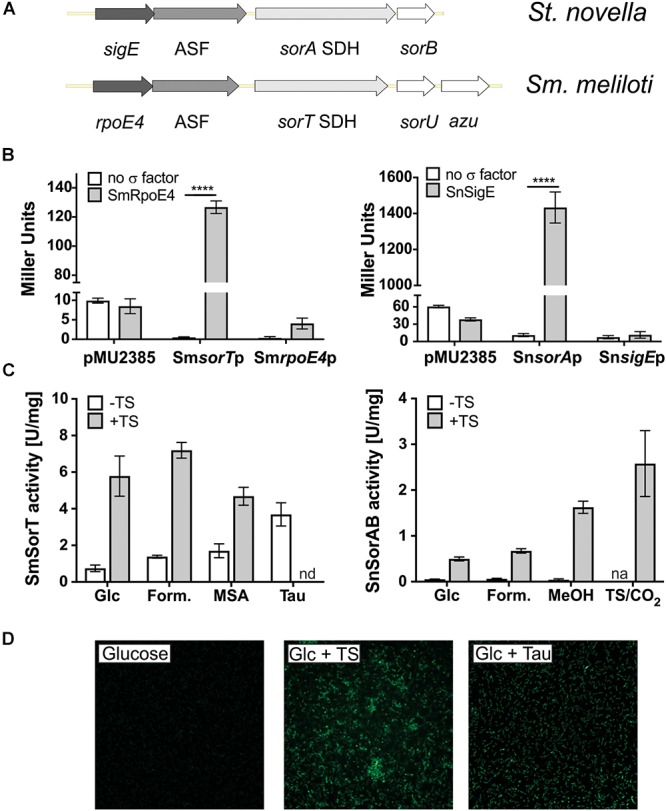
ECF sigma factor-based regulation of SOE gene expression in Sm. meliloti 1021 and St. novella. (A) Schematic representation of the Sm. meliloti rpoE4/sorT and St. novella sigE/sorAB gene regions, highlighting the similarity of the gene arrangement. (B) Reporter gene assays showing the ability of SmRpoE4 and SnSigE to activate the promoters of the cognate SOE encoding genes sorT and sorA. Controls shown test the activity of promoter gene fusions in the absence of a specific transcription factor (white columns) and the ability of the transcription factors to increase expression of the promoterless lacZ gene in pMu2385 (Label: pMu2385), respectively. Positive interactions between test promoters and sigma factors lead to increase beta-Galactosidase activity, 2-way ANOVA: ∗∗∗∗p < 0.0001. (C) Carbon and sulfur substrate dependent changes in SOE activity in Sm. meliloti 1021 and St. novella, highlighting the different modes of basal regulation. Enzyme activities were determined in cell extracts from cultures grown to late exponential growth phase on the indicated substrates using ferricyanide-based (Sm. meliloti SorT) or cytochrome c-based (St. novella SorAB) assays. The growth substrates chosen reflect the different substrate preferences of the bacteria. (D)
In vivo induction of sorT promoter-gfp mut2 fusions in Sm. meliloti growing on media with different growth substrates. Fluorescence changes correspond to SOE activity changes shown in (C). Data in (B,C) represent averages of at least three repeat assays (n = 3 biological replicates), error bars represent standard deviation. Abbreviations: ASF, antisigma factor; Azu, azurin; cyt.c, cytochrome c; Form., formate; Glc,-glucose; MeOH, methanol; MSA, methanesulfonic acid; n.d., not determined; n.a., not applicable; Tau, taurine; TS, thiosulfate.